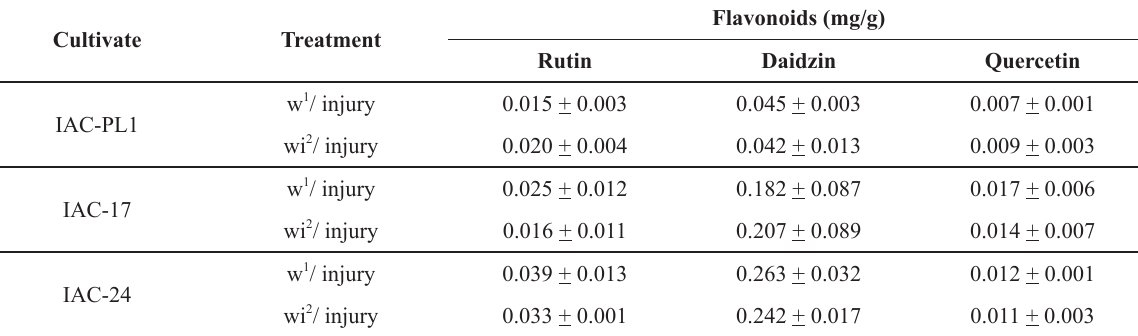
Concentration of flavonoids rutin, daidzein and quercetin (mg/g) in insect resistant and susceptible soybeans with and without mechanical